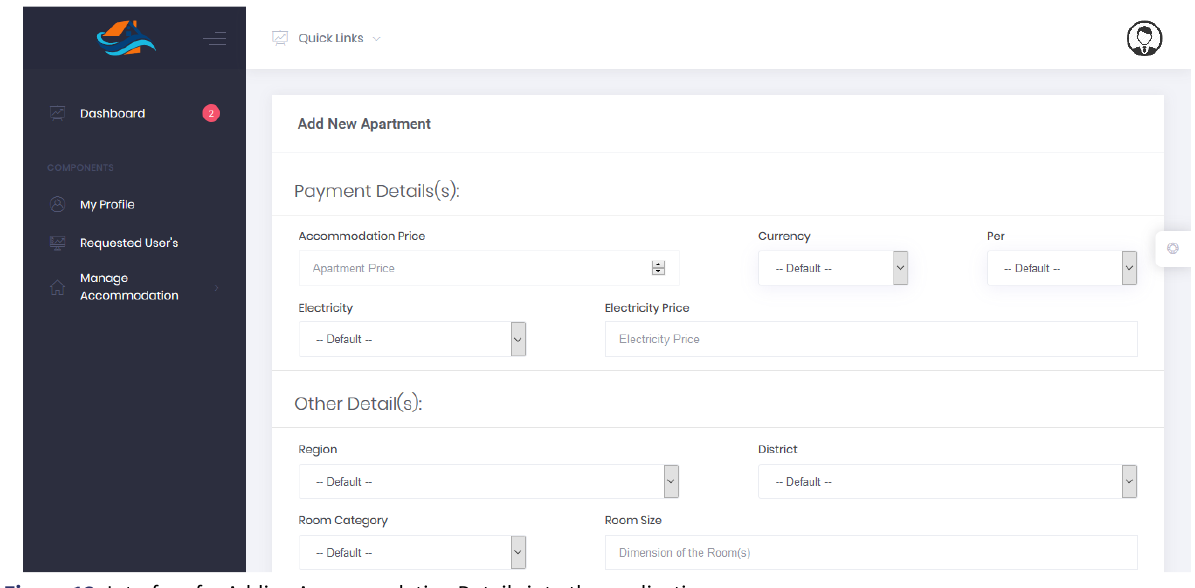
Figure 13. Interface for Adding Accommodation Details into the application